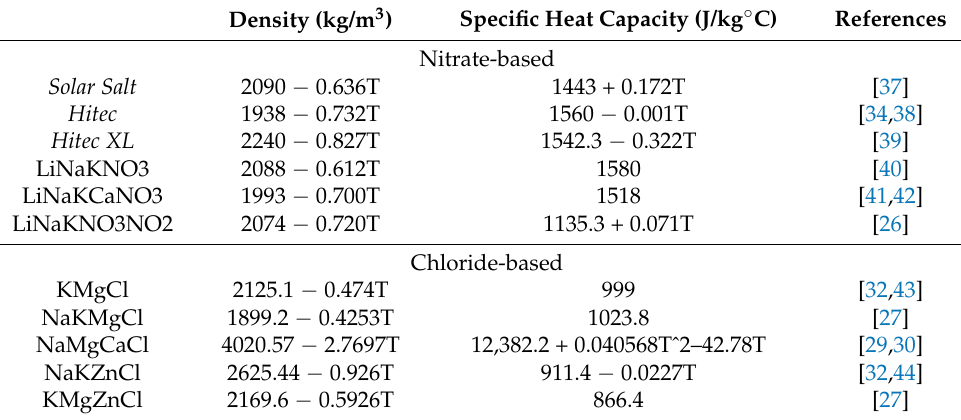
Table 2. Properties of selected molten salt TES